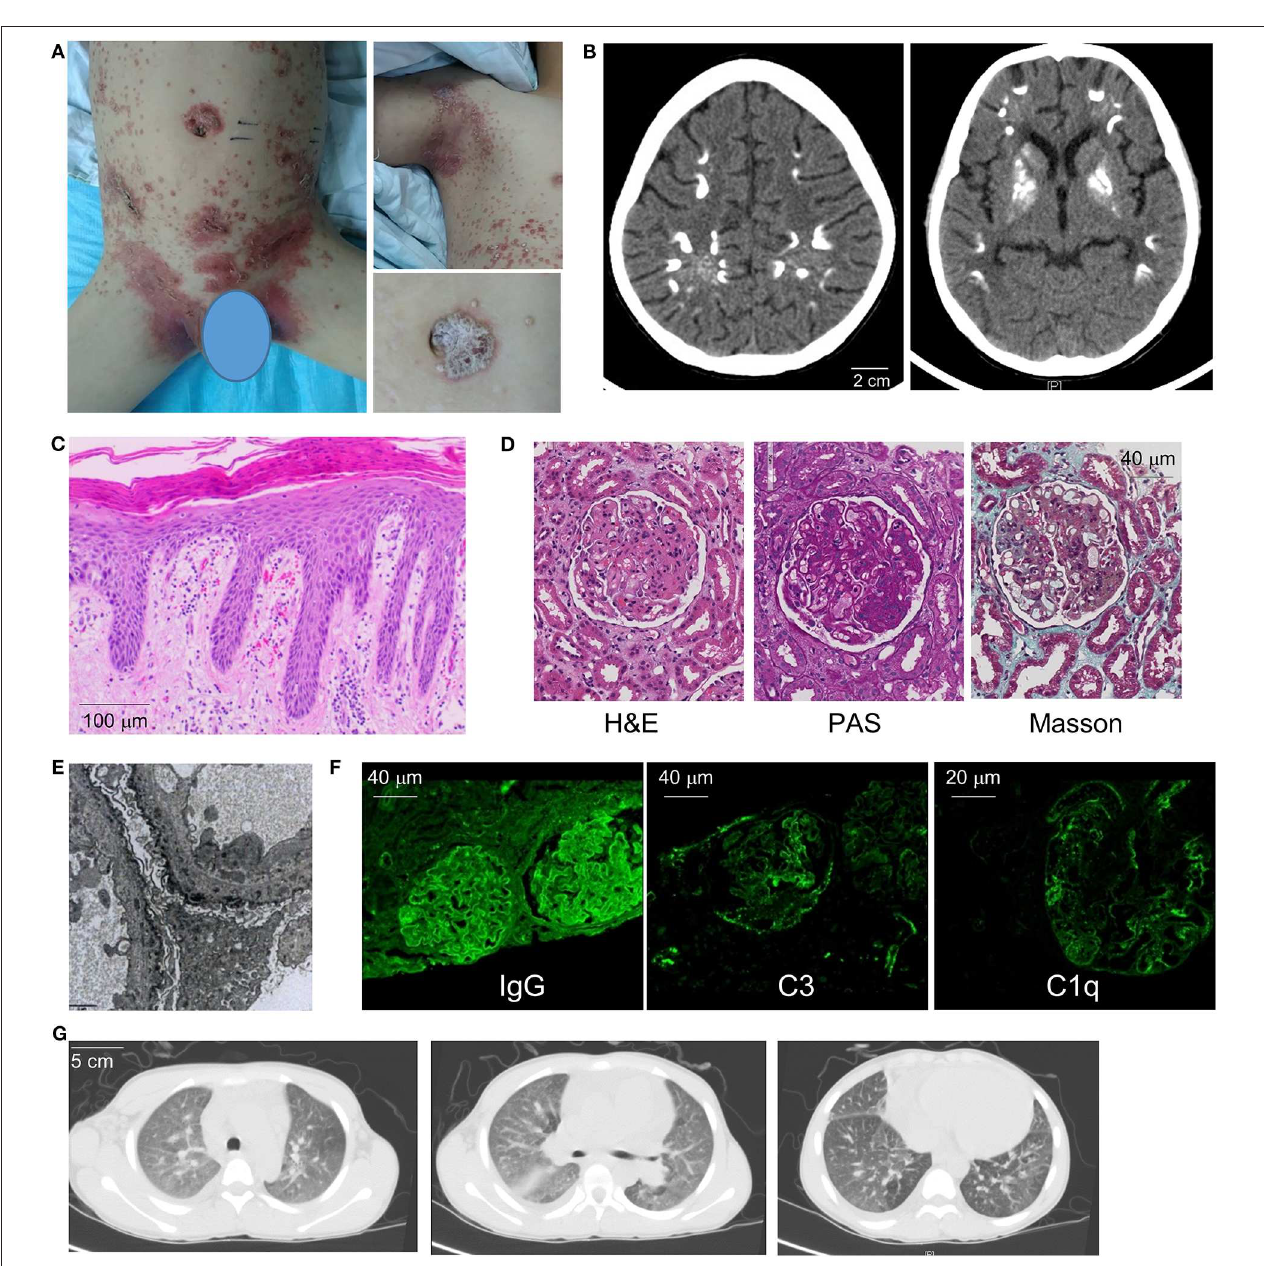
FIGURE 1 | Clinical manifestations and diagnostic evaluation. (A) Images of the patient’s generalized psoriatic rash in the trunk (left) and axilla (upper right) at the time of initial presentation. Magnified panel (lower right) illustrates features of plaque psoriasis. (B) Brain CT demonstrates areas of calcification in the cerebral cortex and basal ganglia. (C) Skin biopsy illustrates hallmark features of psoriasis including hyperkeratosis, dilated capillary loops with a perivascular lymphocytic infiltrate, mild dermal edema, and regular psoriasiform epidermal hyperplasia with elongation of the rete ridges. (D) Renal biopsy pathology (H&E, PAS, and Masson’s stains) illustrates membranous nephropathy and mesangial hyperplasia. (E) Electron microscopy of renal tissue demonstrates electron-dense deposits along the basement membrane (8000 × magnification). (F) Immunofluorescence of renal tissue reveals positive glomerular staining for IgG, complement C3 and C1Q. (G) Chest CT images illustrate small pleural effusion, diffuse ground-glass opacities, and emphysema of lower